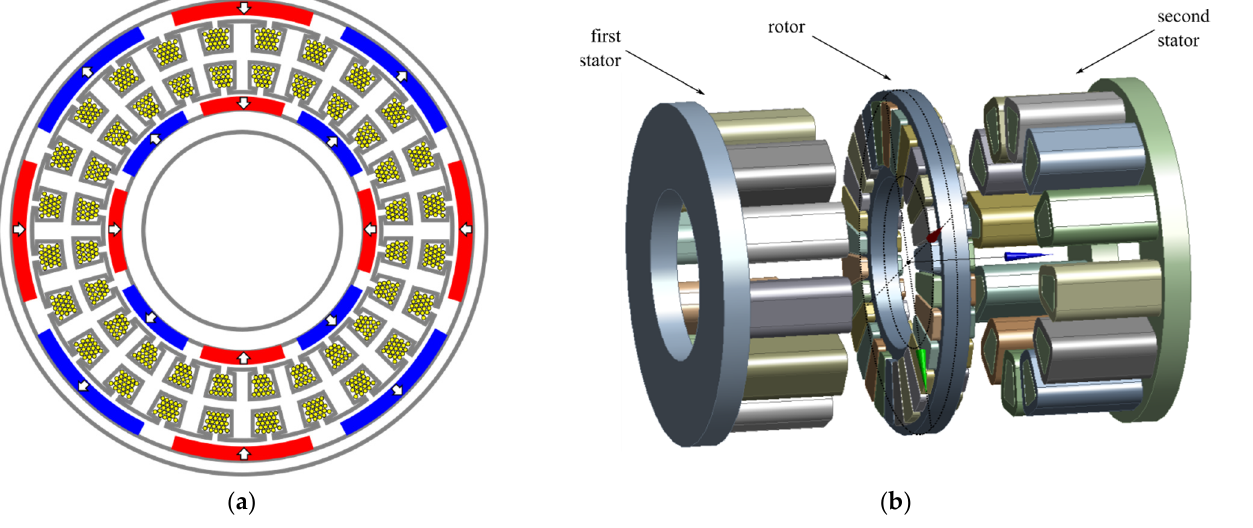
Figure 7. Double rotor and stator PM machines: ( a ) dual rotor radial field PM machine [73]; ( b ) double stator axial field PM machine [75]. This machine can have multiple stages, thus increasing the cooling complexity even further.